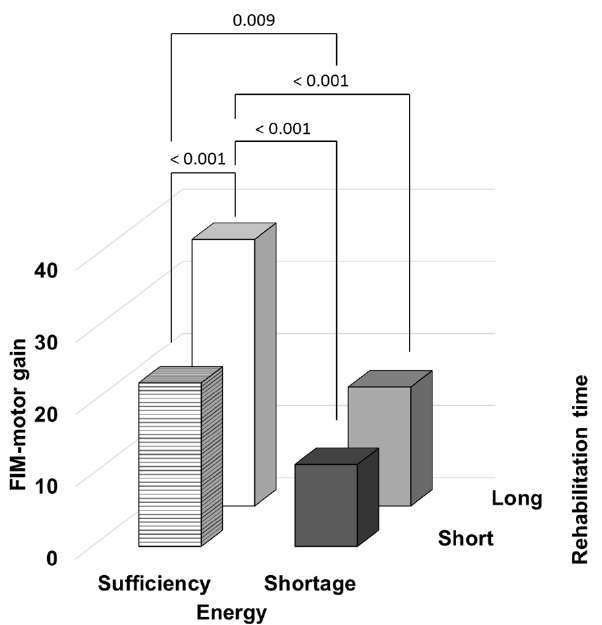
Figure 2. Comparison of the FIM-motor gain among the groups. The patients were categorized into four groups based on their energy intake during the first week of hospitalization (sufficient/shortage) and rehabilitation time (long/short). Black bar represents “Short × Shortage”, gray bar represents “Long × Shortage”, horizontally striped bar represents “Short × Sufficiency”, and white bar represents “Long × Sufficiency”.